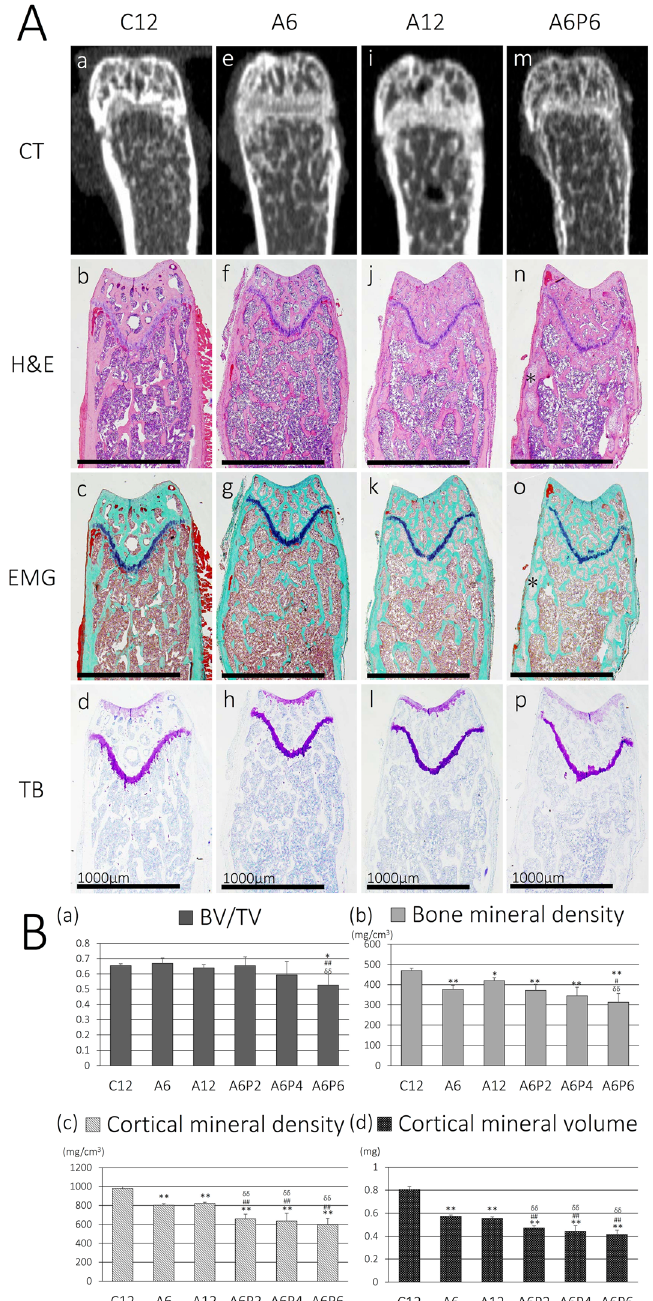
Figure 6. Representative histological images of the distal thighbone and morphometric parameters of distal femoral metaphysis. ( A ) Histological images from the control (C12; b–d), A6 (f–h), A12 (j–l), and A6P6 (n–p) groups are shown. For the CKD-HP groups, images from A6P6 mice are shown, with the greatest evidence of the characteristic changes in the CKD-HP groups. Although changes in the morphology of the diaphysis and irregularity of cortical bones was evident in all CKD groups (e–p), these changes were particularly strong among CKD-HP mice (m–p), with evidence of some cortical regions replaced by loose tissues (n,o; asterisk, * ). Scale bar, 1000 μ m. ( B ) Morphometric parameters (BV/TV, BMD, CMD, and CMV) were calculated through analysis of CT images, to identify most depressed morphometric parameters in the CKD-HP groups. CT, computed tomography; H&E, hematoxylin and eosin; EMG, elastica Masson-Goldner; TB, toluidine blue; BV/ TV, bone volume/tissue volume; BMD, bone mineral density; CMD, cortical mineral density; CMV, cortical mineral volume. The data are represented as the mean ± SEM (n = 5); * P < 0.05 and ** P < 0.01 versus C12; # P < 0.05 and ## P < 0.01 versus A6; δδ P < 0.01 versus A12; all P -values are evaluated by non-repeated measures